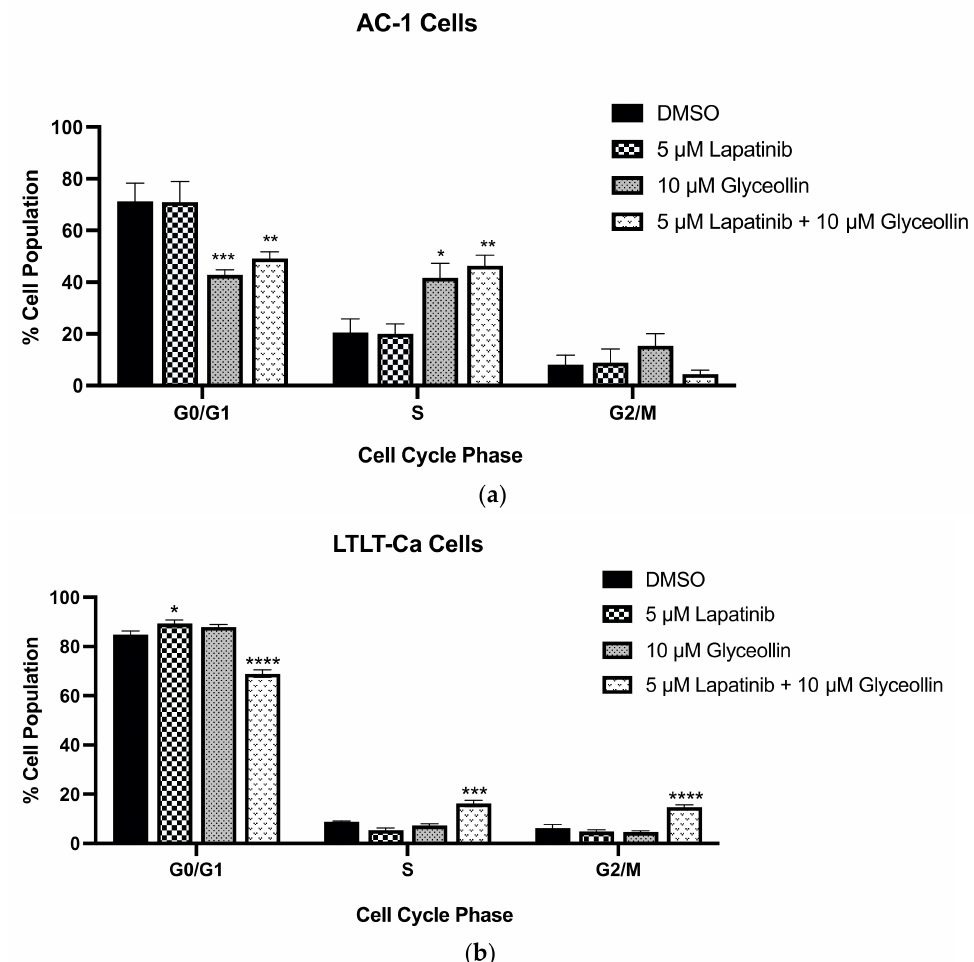
Figure 5. Glyceollin alone and in combination with lapatinib inhibits G1/S and G2/M cell cycle progression in LTLT-Ca cells. ( a ) The AC-1 and ( b ) the LTLT-Ca cells were assessed by flow cytometry for cell cycle progression after treatment with the vehicle control (DMSO), 5 µ M lapatinib, 10 µ M glyceollin, and 5 µ M lapatinib + 10 µ M glyceollin for 48 h. Cells were detached, washed, fixed, and stained with propidium iodide. Cell cycle analysis was determined as described in the methodology. Two-way ANOVA analysis were performed, and treatments were compared to the DMSO control. Results are expressed as a percentage of total cells ± SD (**** p < 0.0001, *** p < 0.001, ** p < 0.01, * p < 0.05) of three independent experiments in